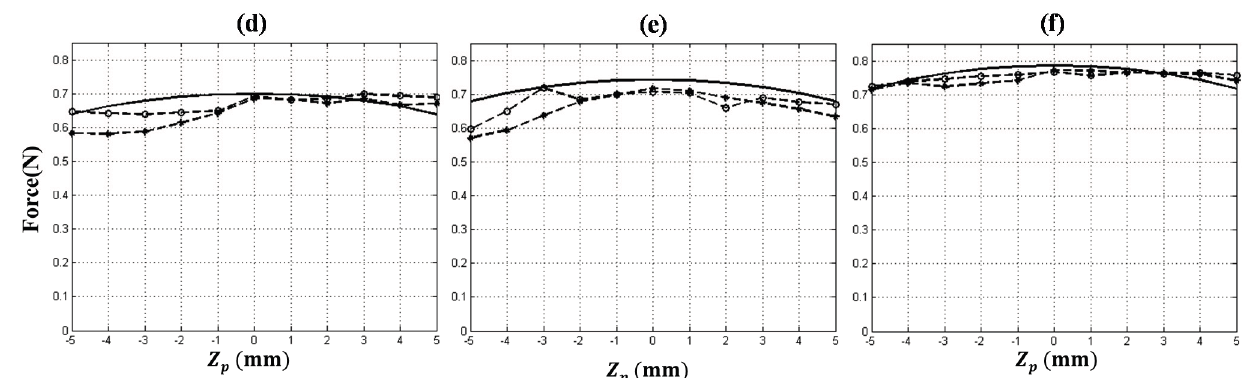
Figure 7. The resultant magnetic forces as a function of the plunger position z p from the solenoid center for various coil turns: ( a ) 1100 turns; ( b ) 1200 turns; ( c ) 1300 turns; ( d ) 1400 turns; ( e ) 1500 turns; ( f ) 1600